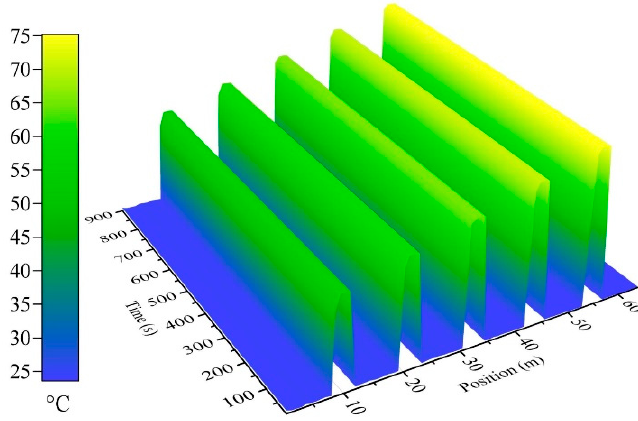
Figure 5. Hot region detecting accuracy test result.